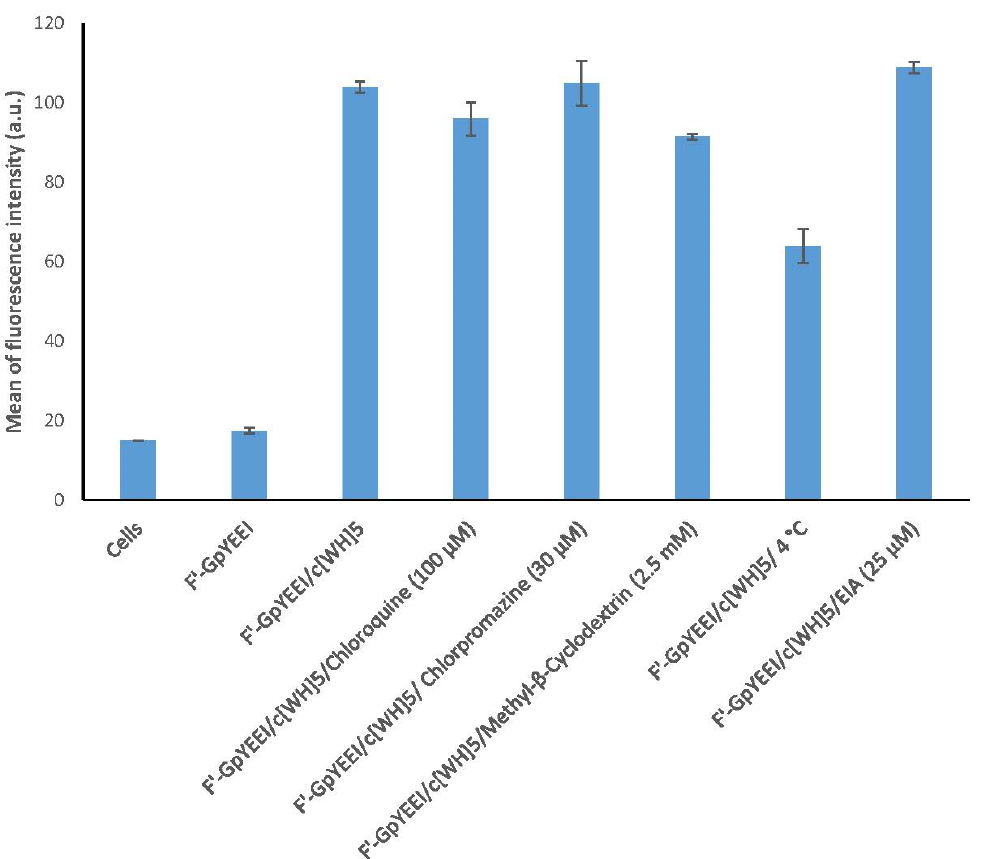
Figure 4. Intracellular uptake of F’ ‐ GpYEEI by cyclic [WH] 5 in CCRF ‐ CEM cancer cell lines.